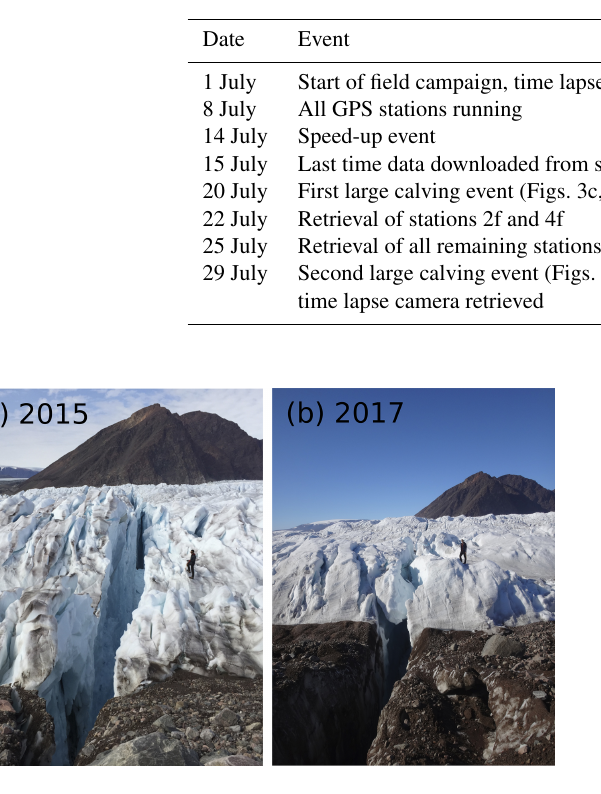
Figure 2. Pictures of the deep crevasses at the calving front in July 2015 ( a ; date unknown) and 6 July 2017 (b) that both led to large-scale calving events, both with a person for scale. ( a ) Credit: E. Podolskiy; ( b ) credit: L.